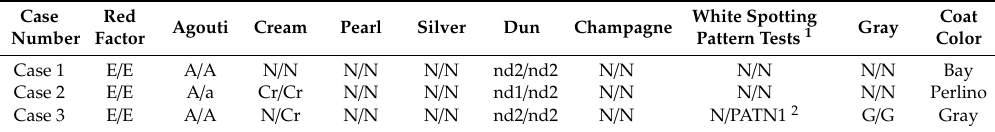
Table 3. Coat color genotype results determined for the three ocular SCC cases.